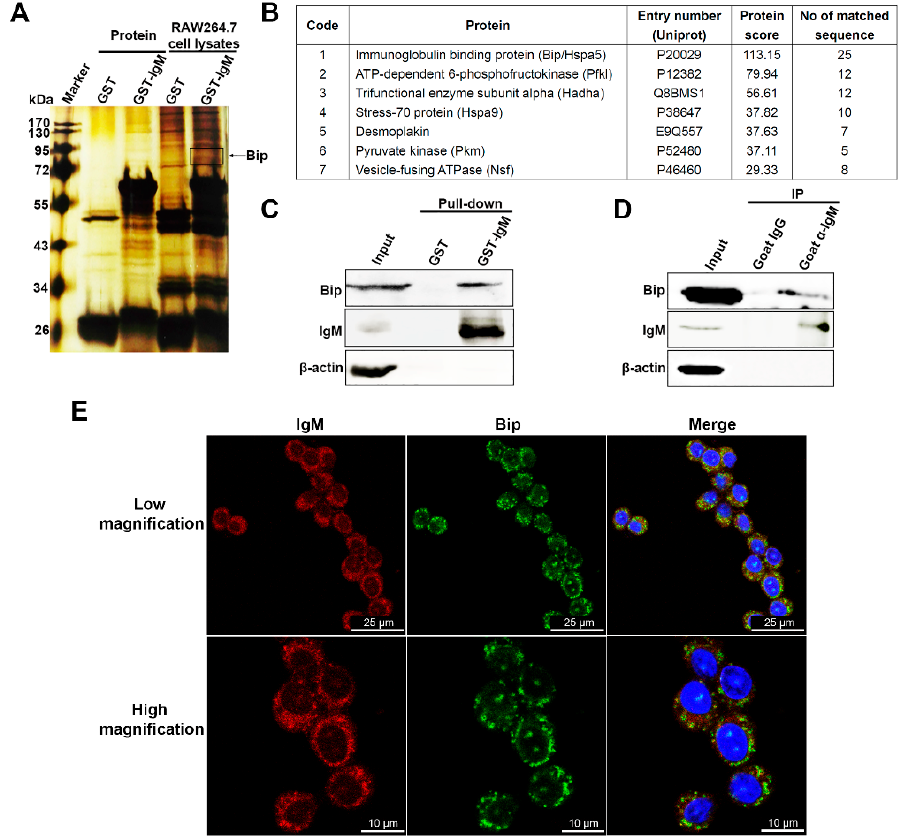
Figure 5. IgM interacted with Bip in RAW264.7 cells. ( A ) Whole cell lysate derived from RAW264.7 cells was used to pull down with the same amount of GST-IgM recombinant protein or GST protein as control, respectively. The complexes were separated on SDS-PAGE gels. After silver staining, the differential bands or dots were analyzed by MS. Asterisks and circles indicated for the differential band of Bip. ( B ) Candidates of IgM-associated proteins were identified by liquid chromatography-mass spectrometry. Only part of the identified proteins was shown after removal of repeated proteins and proteins related to the heavy or light chains of the antibody. ( C ) Western blot analysis to determine the interaction between IgM and Bip in GST-pull down assay. ( D ) The interaction between endogenous IgM and Bip was shown in the coimmunoprecipitation assay. The cell lysate of RAW264.7 cells was immunoprecipitated with goat anti-IgM antibody and goat IgG as control. Input, RAW264.7 cell lysate. ( E ) Confocal microscopy analysis of IgM (red) and Bip (green) in RAW264.7 cells using goat anti-mouse IgM polyclonal antibody and rabbit anti-mouse Bip antibody. DAPI (blue) was used for nuclear staining. Scale bars, 25 µ m (Low magnification) and 10 µ m (High magnification).